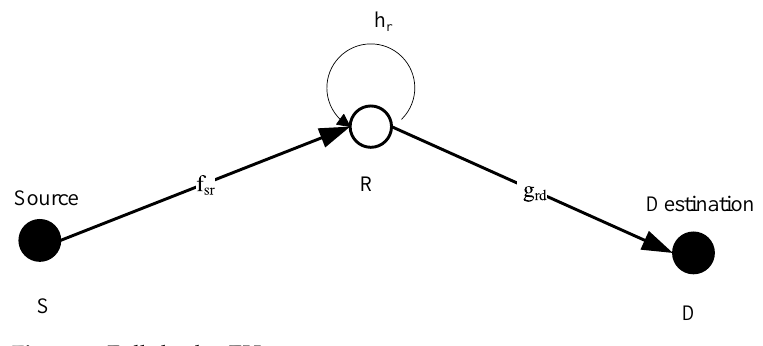
Figure 2. Full-duplex EH system.